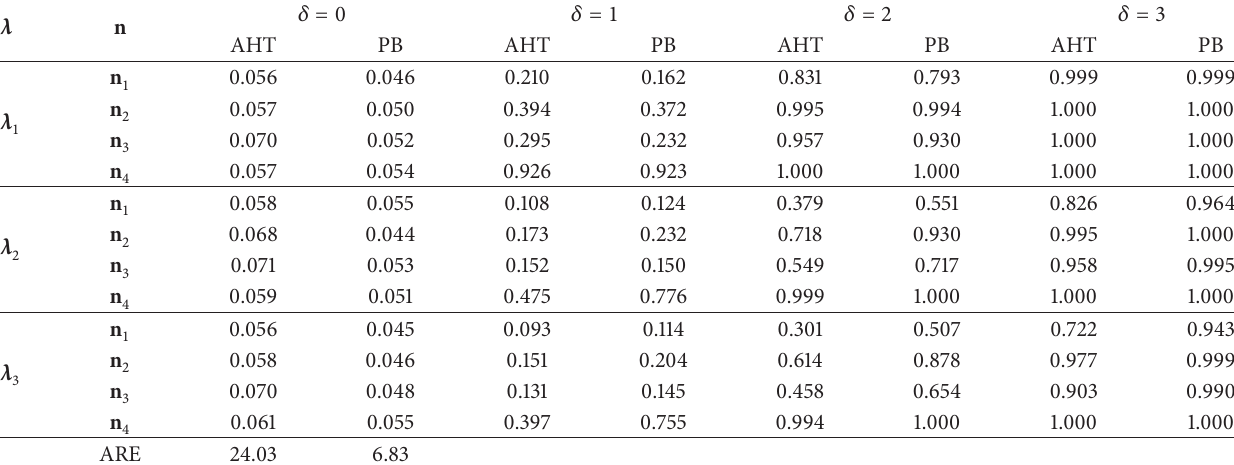
Table 1: Empirical sizes and powers of the two tests for nested effects for bivariate two-factor multivariate nested designs [ 𝑎 = 2, 𝑏 1 = 16, 𝑏 2 = 20